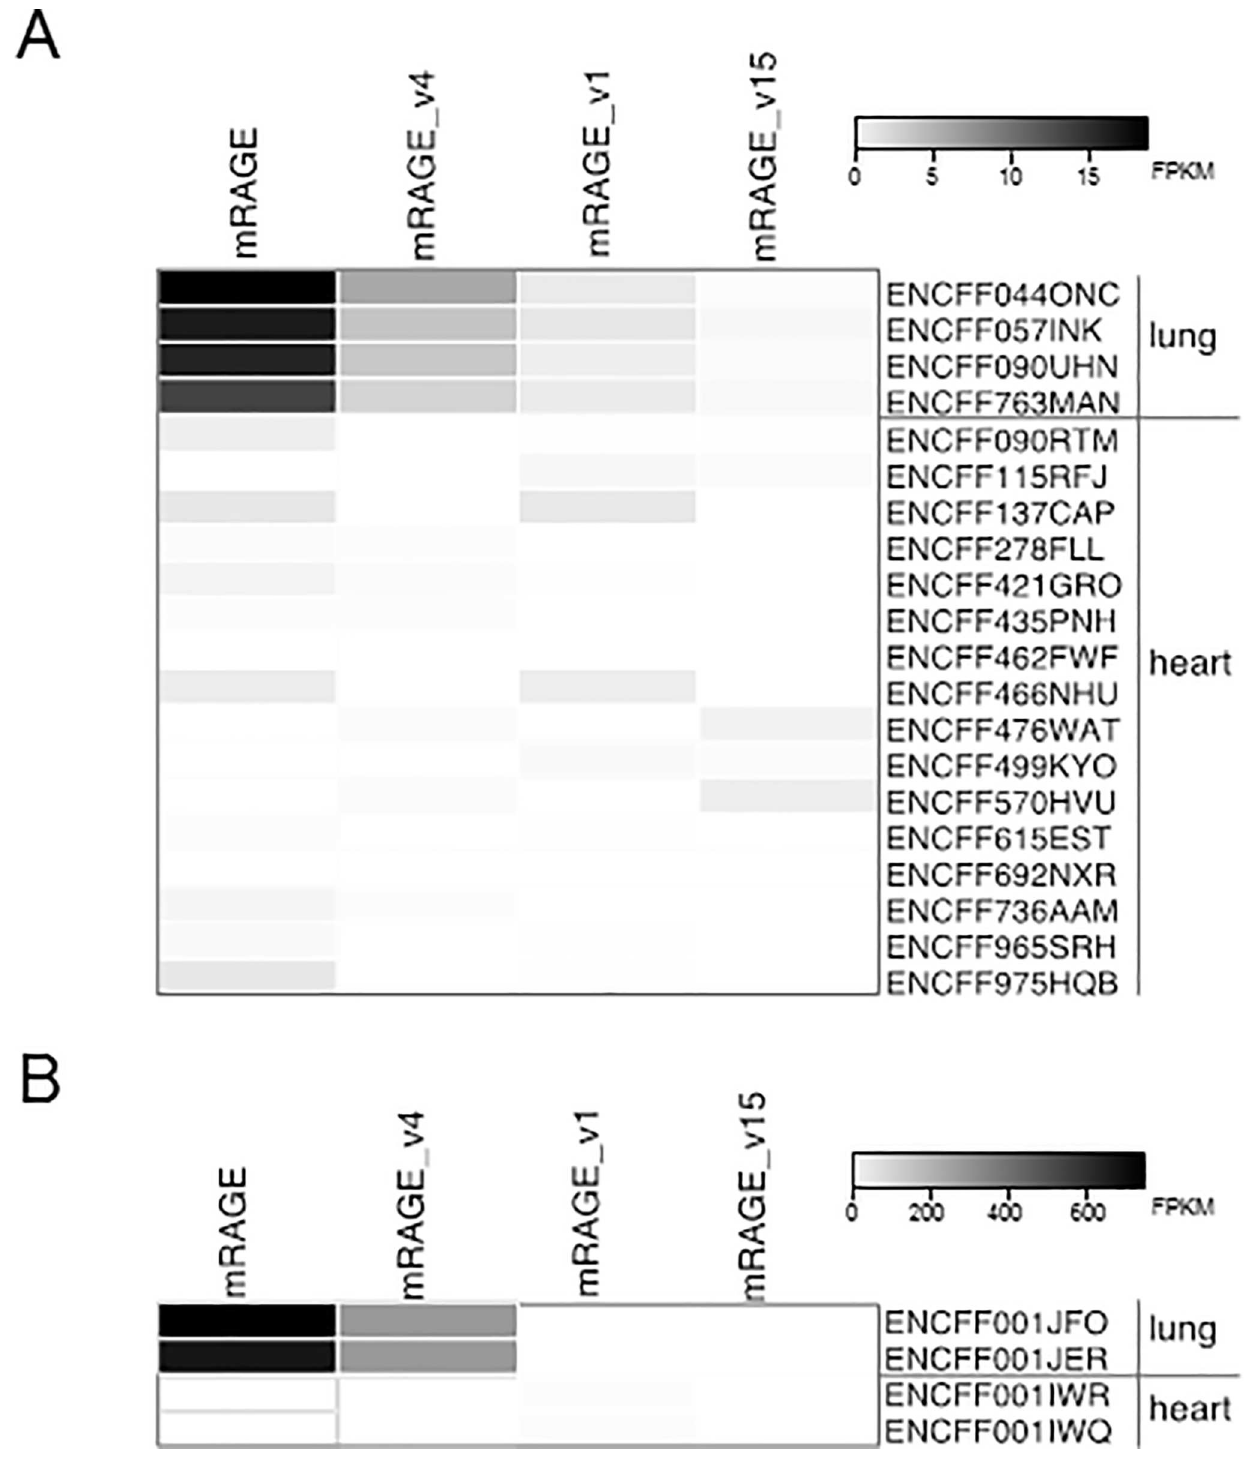
Fig 1. Expression of RAGE transcript variants in different life stages of Mus musculus . The heatmap shows the expression level of indicatedtranscripts of murine Ager gene in lung and heart tissues in embryonic/postnatal (A) and adult samples (B). Scale varies from white (no expression) to black (highest